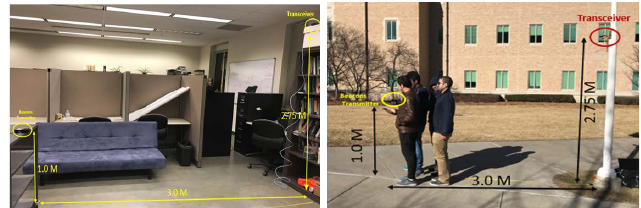
Figure 13. Indoor and outdoor RSSI experiment